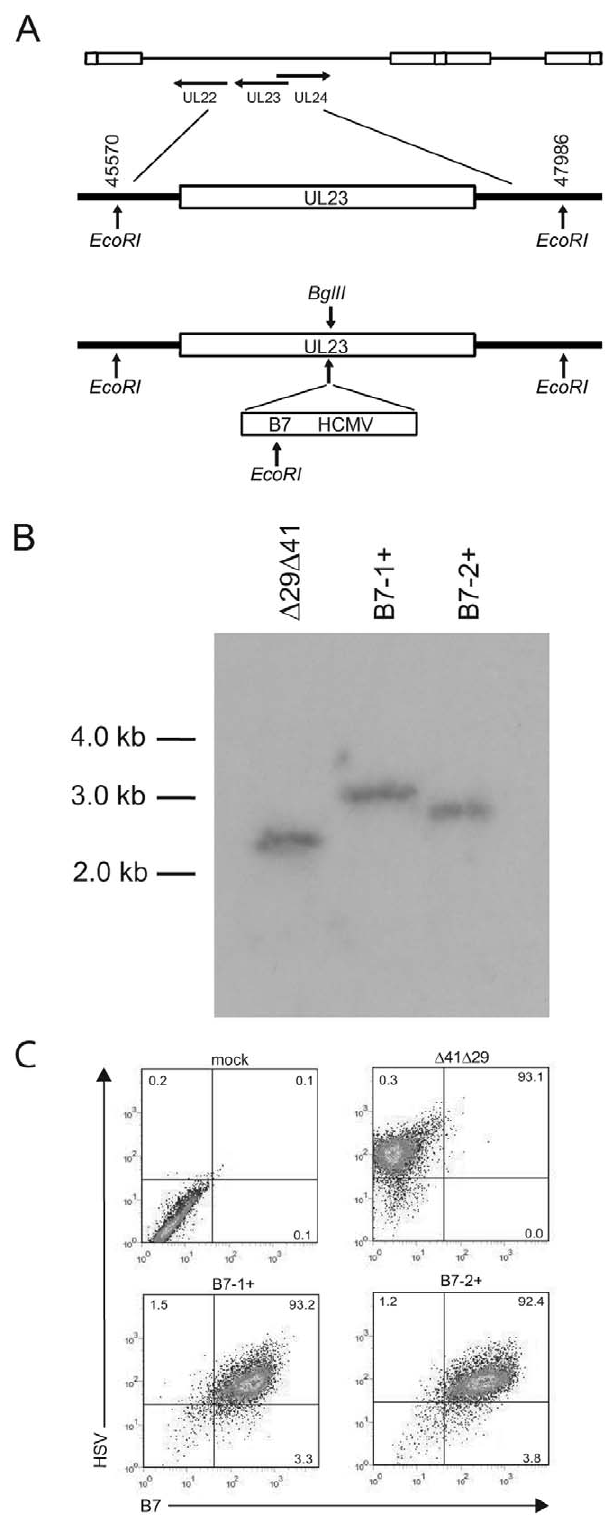
Figure 1. Construction and characterization of B7-expressing viruses. (A) The genomic position of the tk ORF is shown on line 1. An expanded view of this region (line 2) shows the location of EcoRI restriction enzyme sites. Line 3 shows the insertion cassette containing the HCMV IEp fused to either the B7-1 ( D 41 D 29B7-1) or B7-2 ( D 41 D 29B7-2) ORF, each of which contains an EcoRI site near